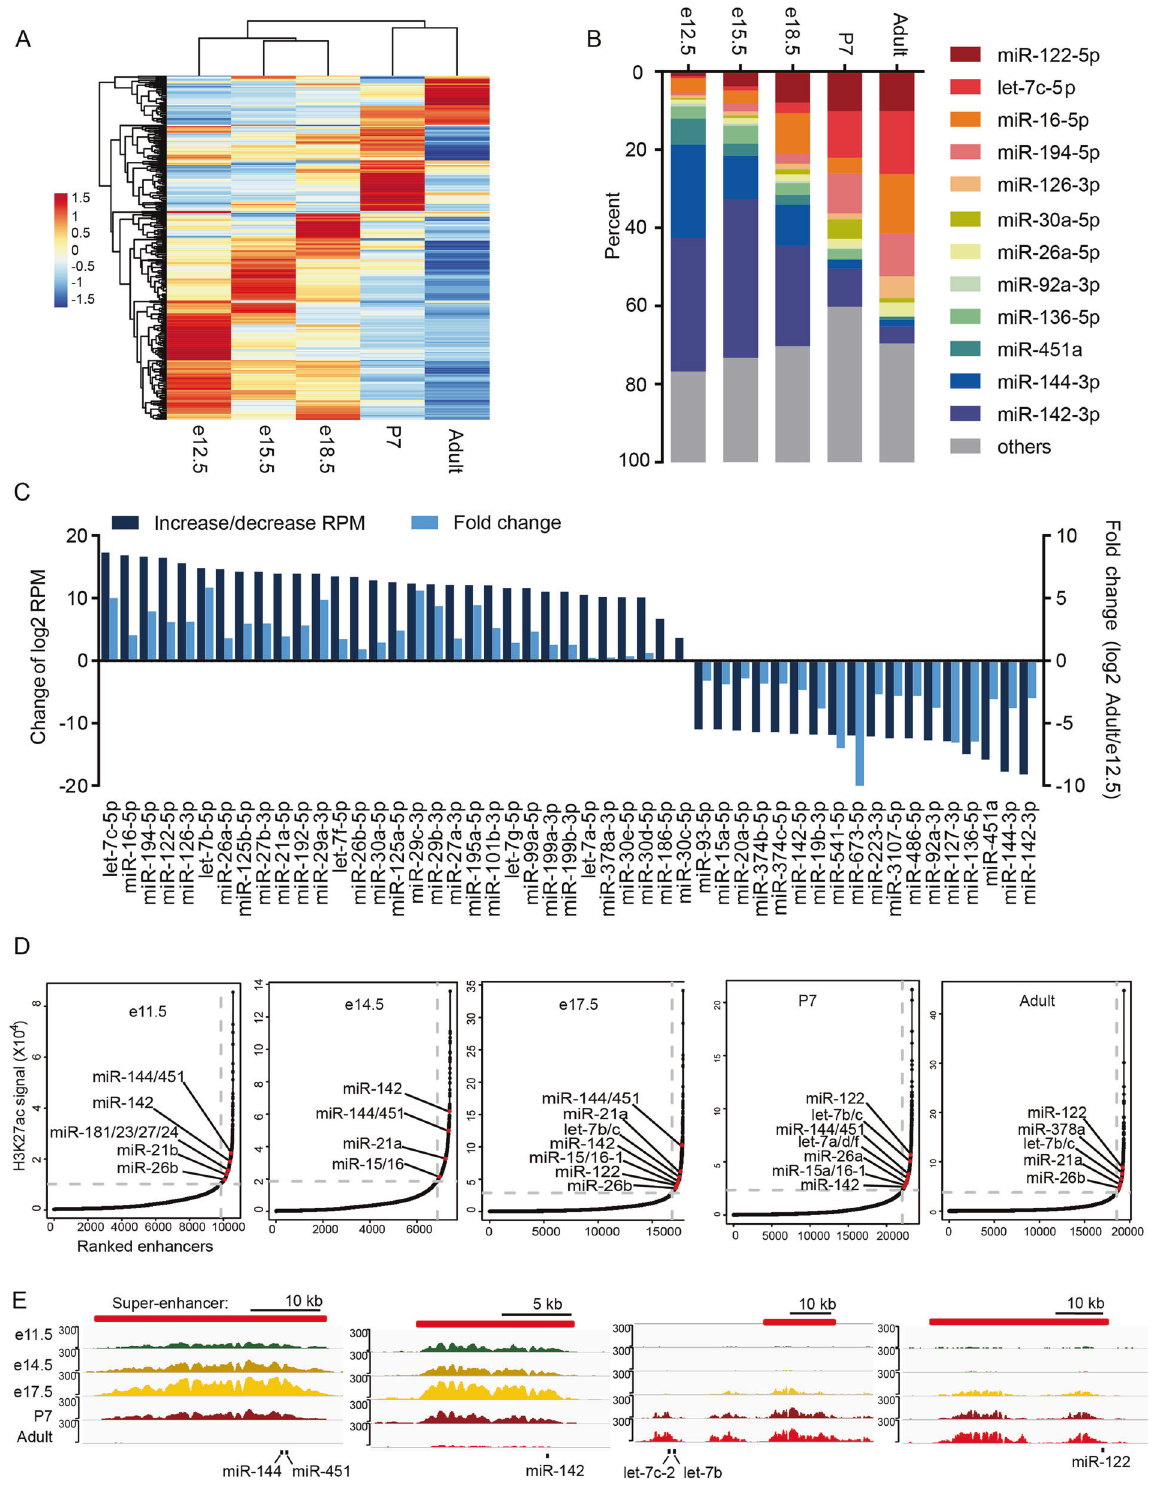
Fig. 2 Dynamic changes of high abundant miRNAs and their epigenetic regulation during mouse liver development. A Cluster analysis of differentially expressed miRNAs during mouse liver development. B Changes in the most highly expressed miRNAs during mouse liver development. C Increase or decrease of miRNA of adult liver compared with e12.5; left Y -axis: increased or decreased FPKM (log2), right Y -axis: log2-fold change. D Hockey stick plots of H3K27ac signals of mouse liver at different developmental stages, super-enhancer-associated miRNAs are highlighted. E ChIP-seq pro fi les of H3K27ac near super-enhancer-associated miRNA loci of mouse liver at different developmental stages. The predicted super-enhancers regions are depicted as red bars. The y -axis represents reads per million (rpm) of ChIP-seq.